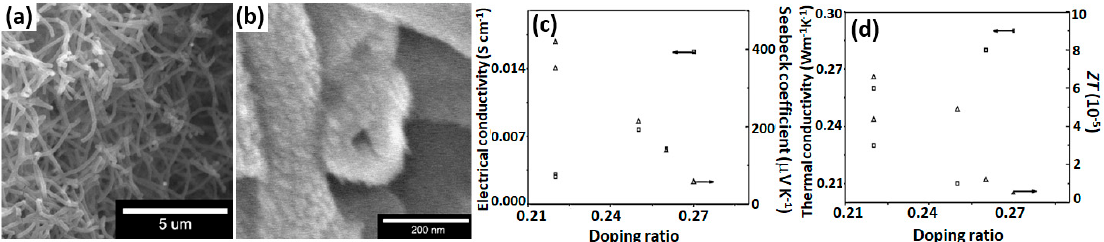
Figure 8. (a and b) SEM images of PANI-NSA nanotubes. (c) Electrical conductivities ( □ ) and Seebeck coefficients ( ∆ ) of PANI nanotubes with different doping ratio. (d) Thermal conductivities ( □ ) and ZT value ( ∆ ) of PANI nanotubes changed with the doping ratio. Readapted with permission from Elsevier B.V. [79].